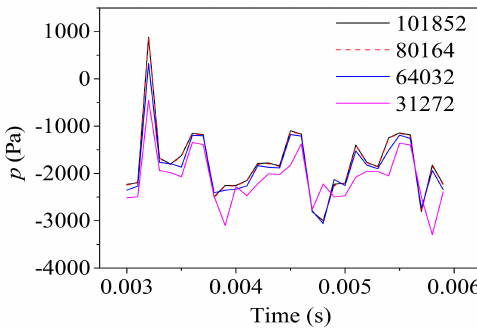
Figure 10. Mesh independence analysis.